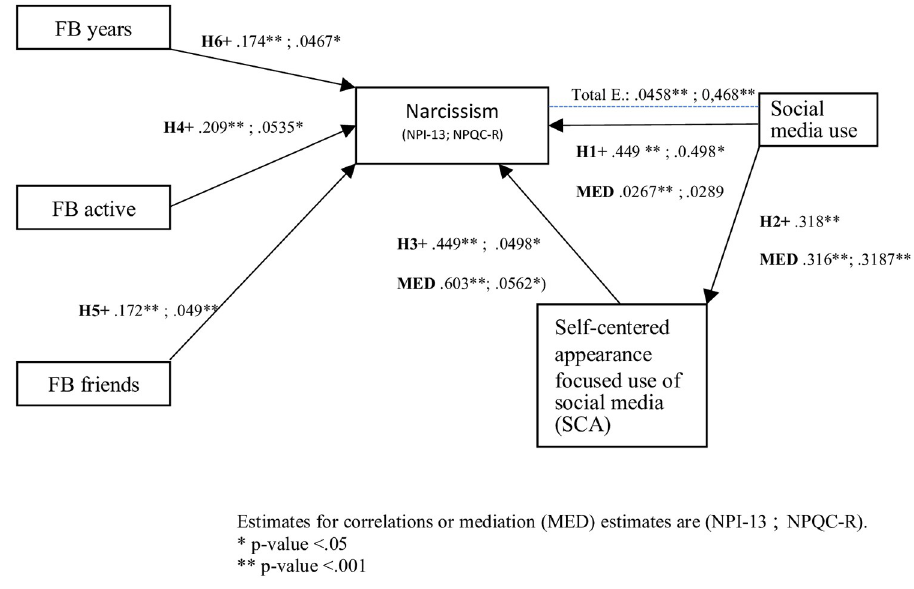
Fig 10. Model of narcissistic social media